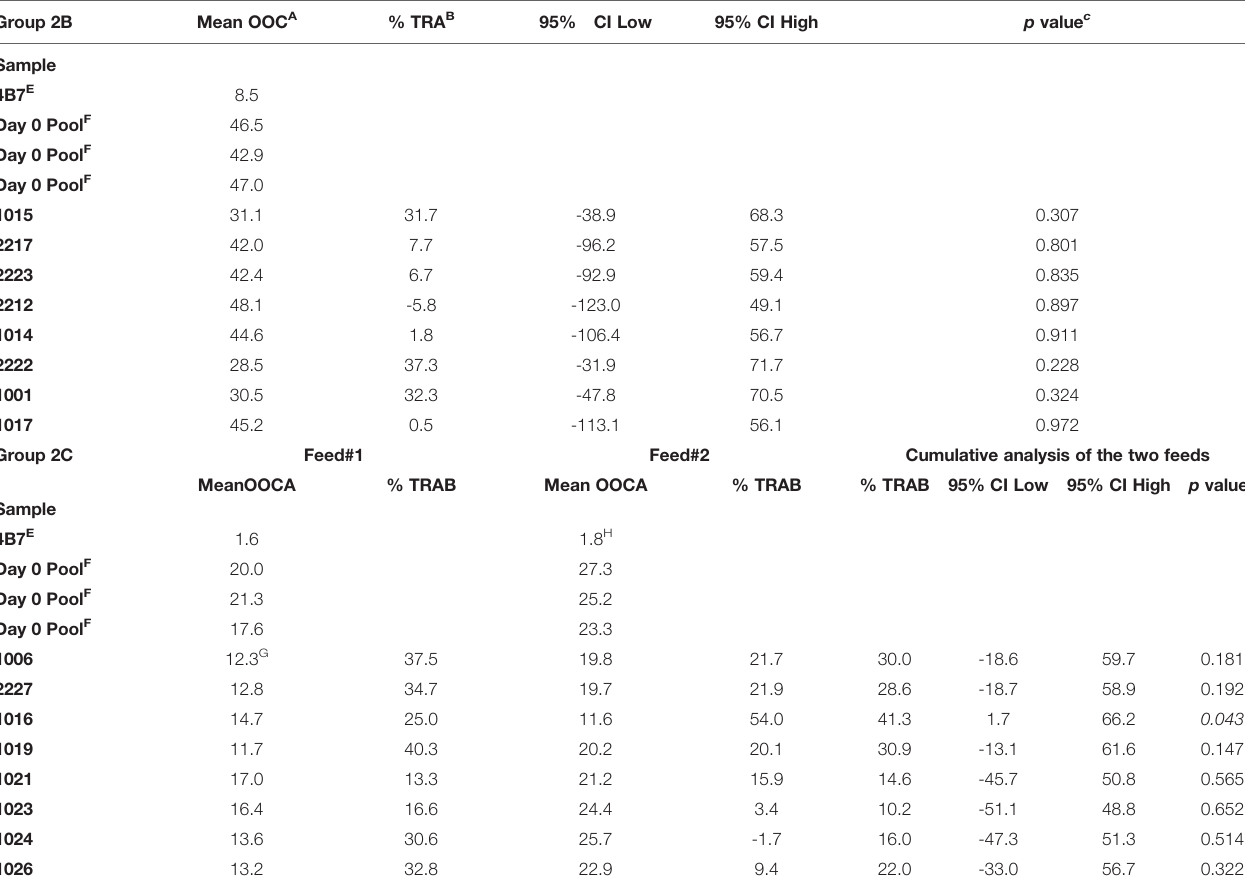
TABLE 1 | Transmission-reducing activity of IgG from individuals of Groups 2B and